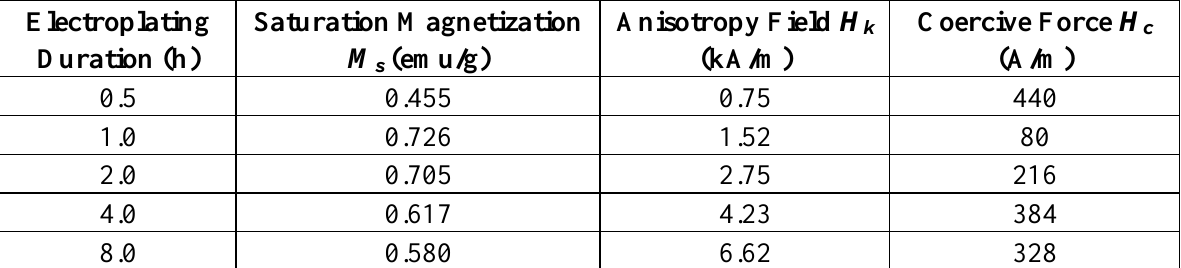
Table 1. The saturation magnetization, anisotropy field, and coercive force of nickel-iron samples of different plating duration.